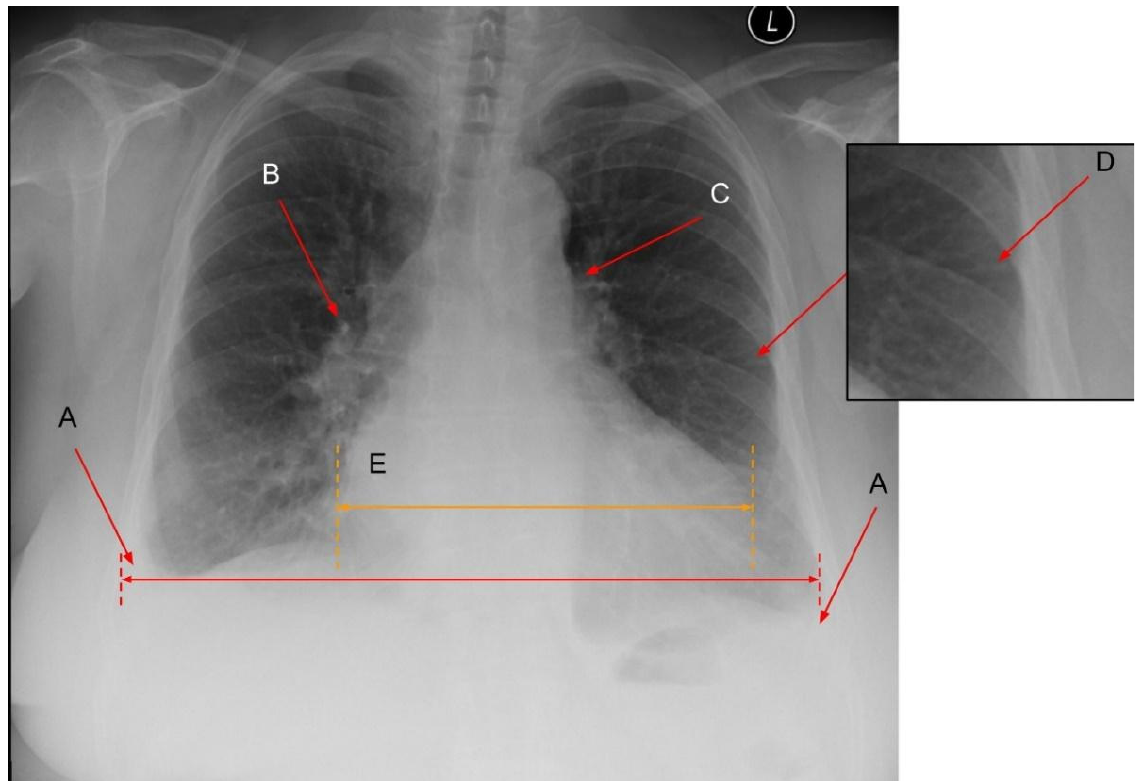
Figure 3. Pulmonary findings in a patient with HF. A: bilateral pleural effusion; B: increased diam- eter of the pulmonary vessels and the hazy contours, enlarged intermediate artery; C: Prominent pulmonary trunk; D: Interstitial oedema (Kerley B lines); E: Increased CTR > 0.5. B and C may signify the presence of pulmonary hypertension. Figure obtained with permission from the 2nd Department of Radiology, Medical University of Warsaw.